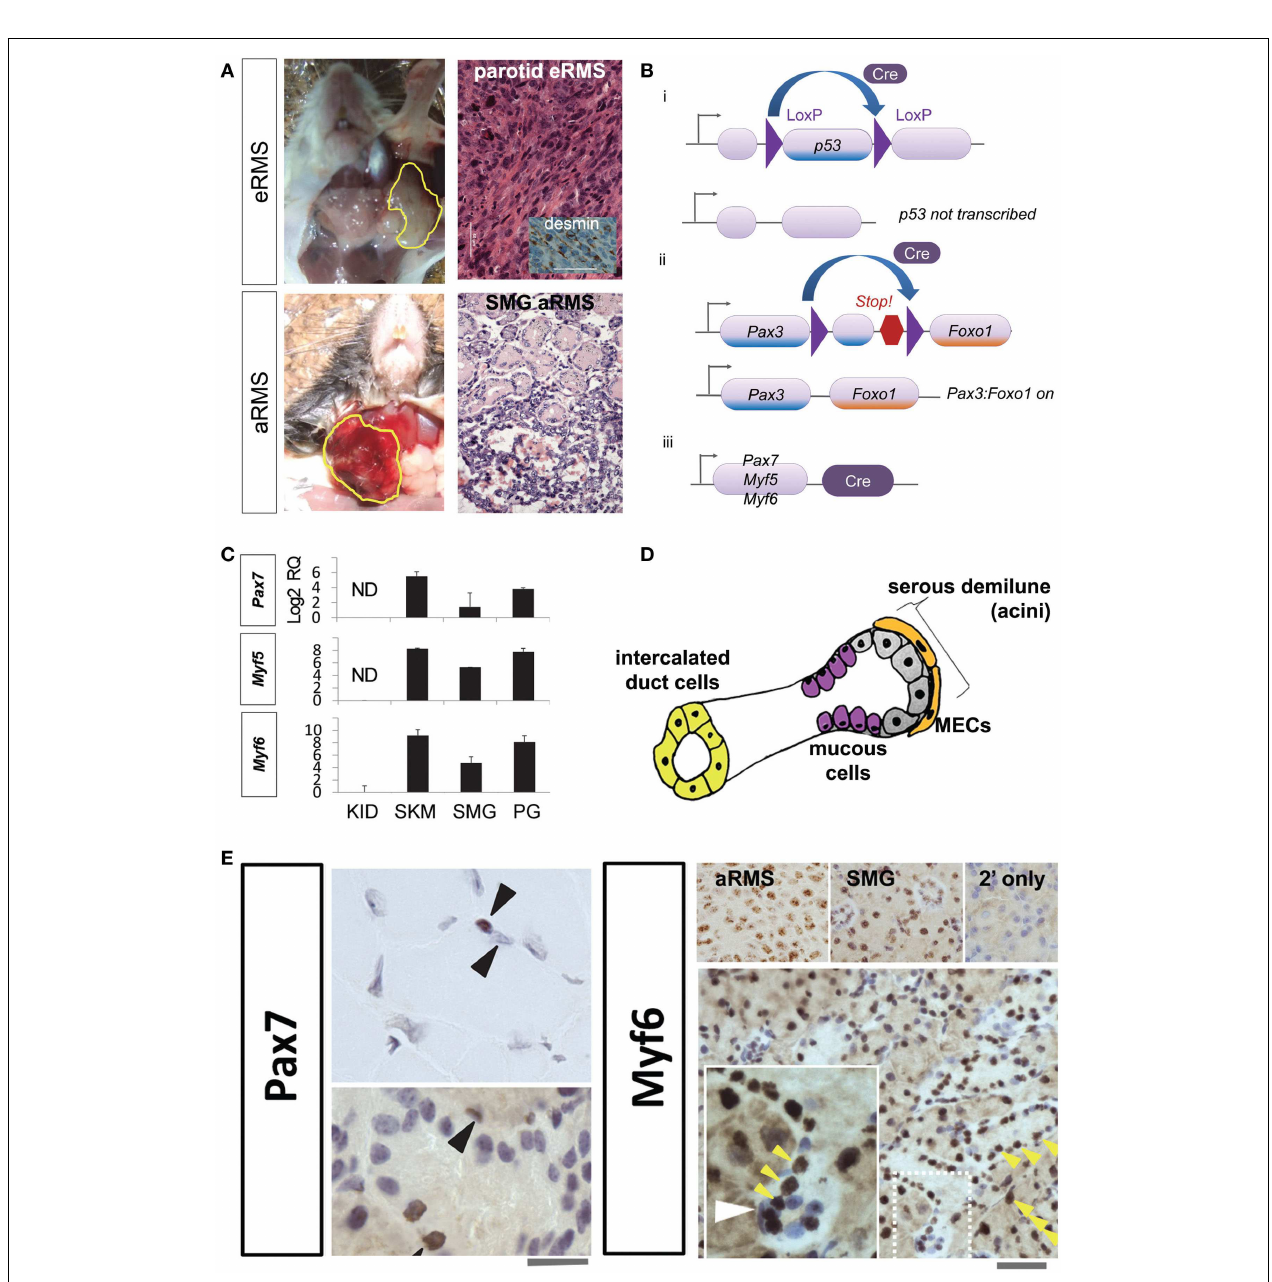
reveals strong Pax7 , Myf5 , and Myf6 expression in the salivary glands and skeletal muscle satellite cells (but not myotube nuclei), and not in renal tissue. (D) Diagrammatic representation of major cell types of the salivary gland. (E) Immunohistochemistry of Pax7 in muscle (top left panel) demonstrates strong expression in the skeletal muscle satellite cell nuclei (brown nucleus, upper arrowhead) but not myotube nuclei (non-brown nucleus, lower arrowhead).The submandibular gland also show numerous cells staining positive for Pax7 (bottom left panel; 10 µ M scale bar) and Myf6 (right bottom panel; 50 µ m scale bar). Myf6 + cells are numerous (yellow arrowheads); however, in the inset a selected slender myoepithelial cells is Myf6 negative (white arrowhead). Abbreviations: eRMS, embryonal rhabdomyosarcoma; aRMS, alveolar rhabdomyosarcoma; SMG, submandibular gland, RMS, rhabdomyosarcoma; RQ, relative quantification; ND, no detectable expression; KID, kidney; SKM, skeletal muscle; PG, parotid gland; MEC, myoepithelial